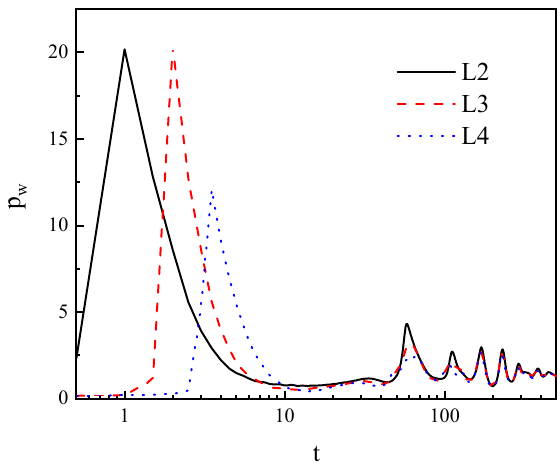
Figure 9. Probe pressure for Cases L2 to L4.